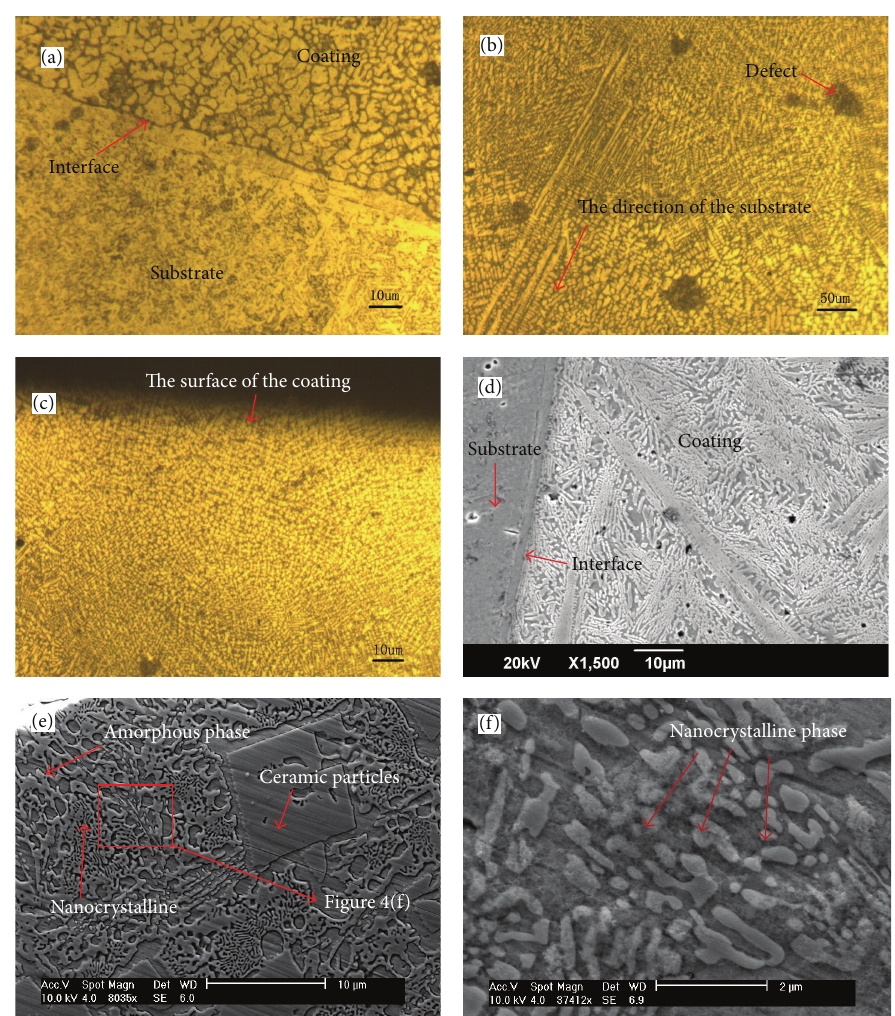
Figure 4: Images of the coatings after remelting: (a) the OM image of the interface of the coating and substrate; (b) the OM image of the center area of the coating; (c) the OM image of the top area of the coating; (d) the SEM image of the coating; (e) the upper region of the coating; (f) amorphous/nanocrystalline